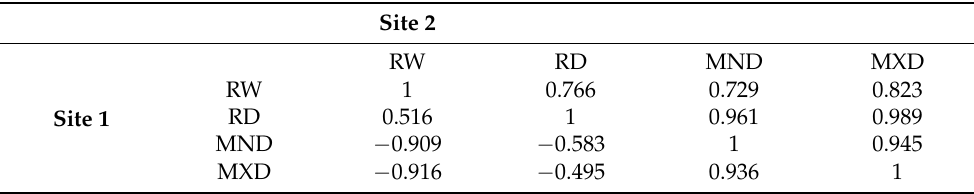
Table 4. Correlation matrix (Pearson bivariate) for ring width and wood density components at site 1 (lower triangle, n = 81) and site 2 (upper triangle, n = 84). RD, average ring density; MND, minimum ring density; MXD, maximum ring density; RW, ring width. Site 2 RW RD MND MXD RW Site 1